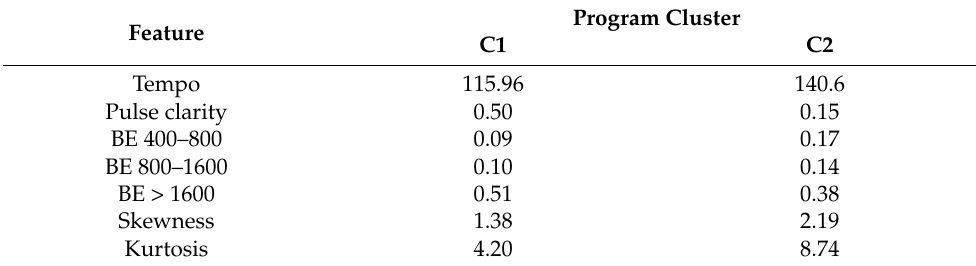
Table 8. Group means of the seven